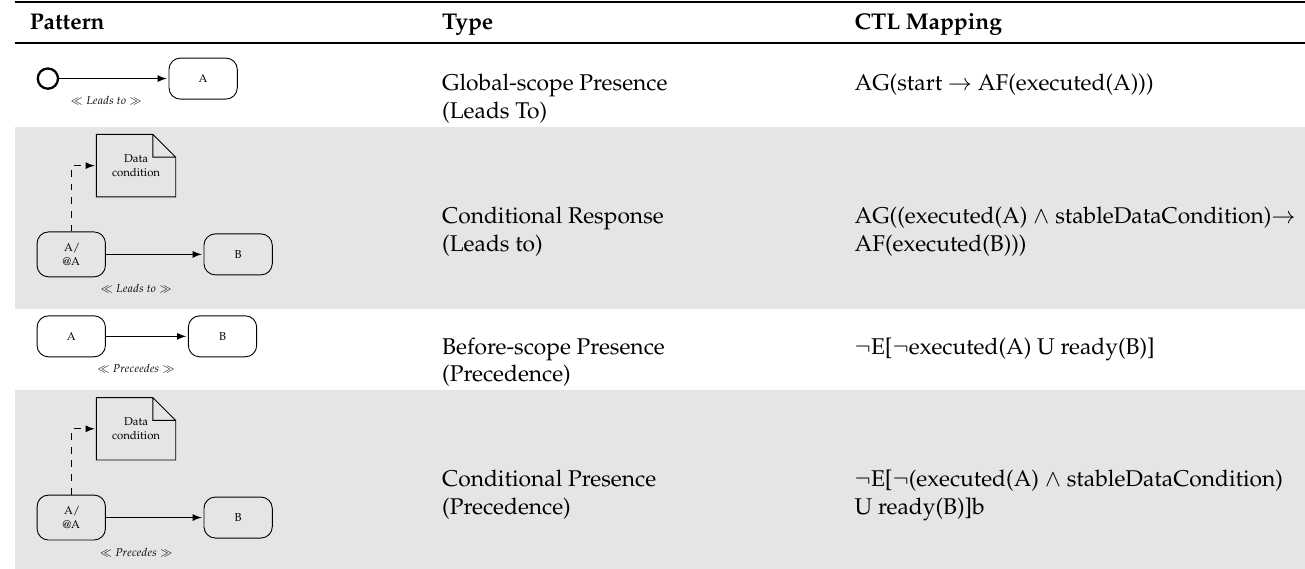
Table 4. Excerpt of BPMN-Q patterns (adopted from